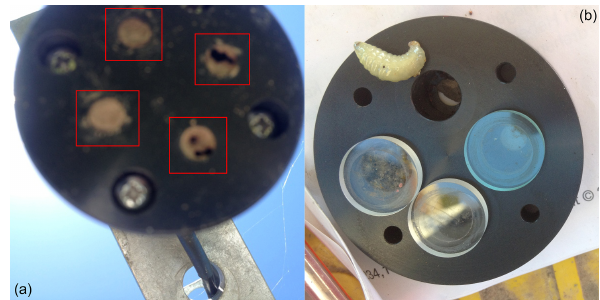
Figure 4. Skye multispectral sensors showing (a) mud wasps and (b) wasp larvae in sensor